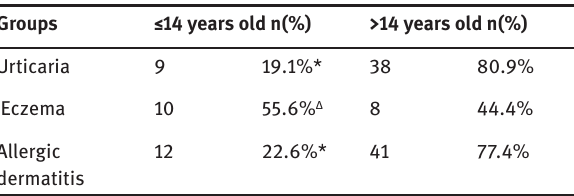
Table 6: Food-specific IgG antibody positive distribution of children and